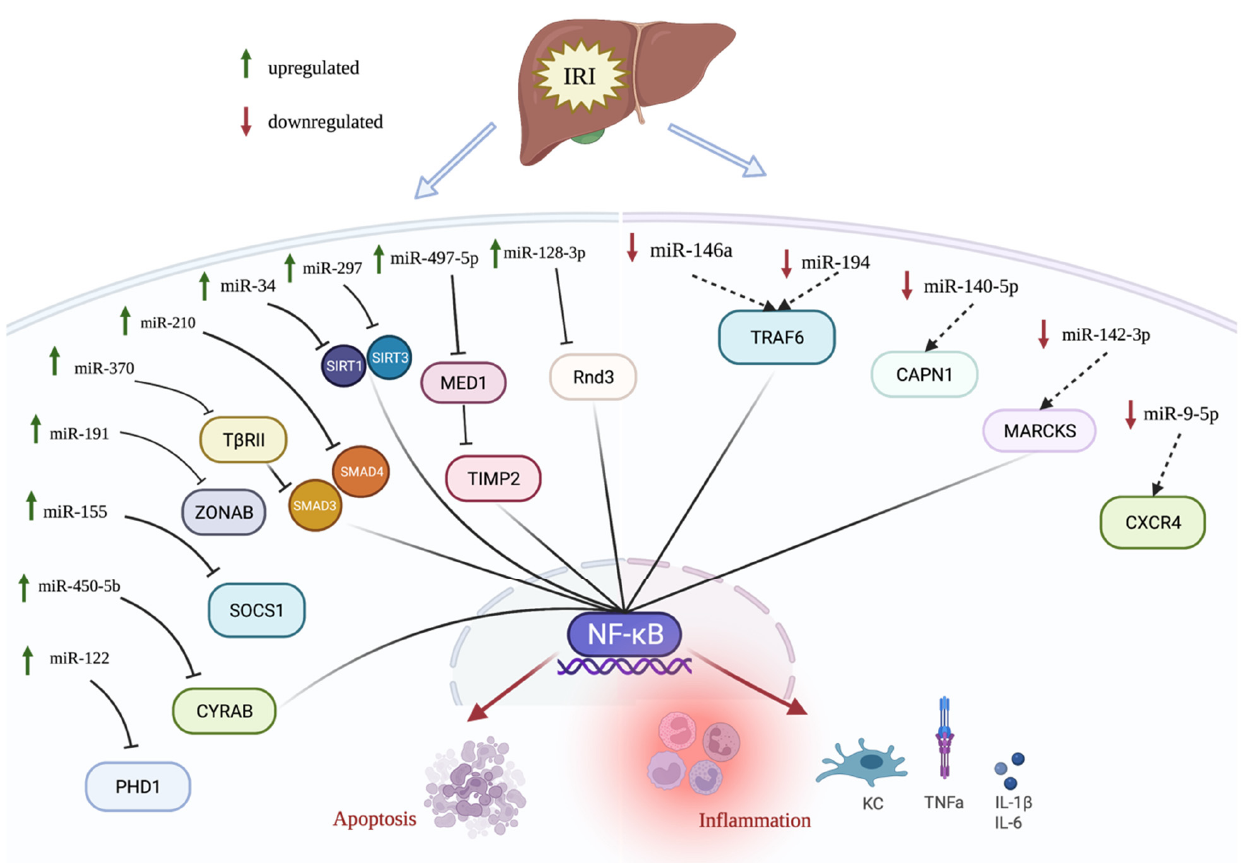
Figure 1. Differentially expressed miRNAs in hepatic IRI. miRNAs that are upregulated in hepatic IRI are indicated by green upward arrow, whereas miRNAs that are downregulated in hepatic IRI are indicated by downward red arrow. miRNAs that regulate NF-kB signaling are connected to NF-kB. For instance, miR-450-5b, miR-370, miR-34, miR-497-5p, and miR-128-3p are upregulated and inhibit their targets, causing an activation of NF-kB pathway during IRI. Reversely, miR-146a, miR-194, and miR-142-3p are downregulated in IRI, and their corresponding targets are upregulated, resulting in activation of NF-kB pathway. Table 1. miRNAs and their function in hepatic IRI.